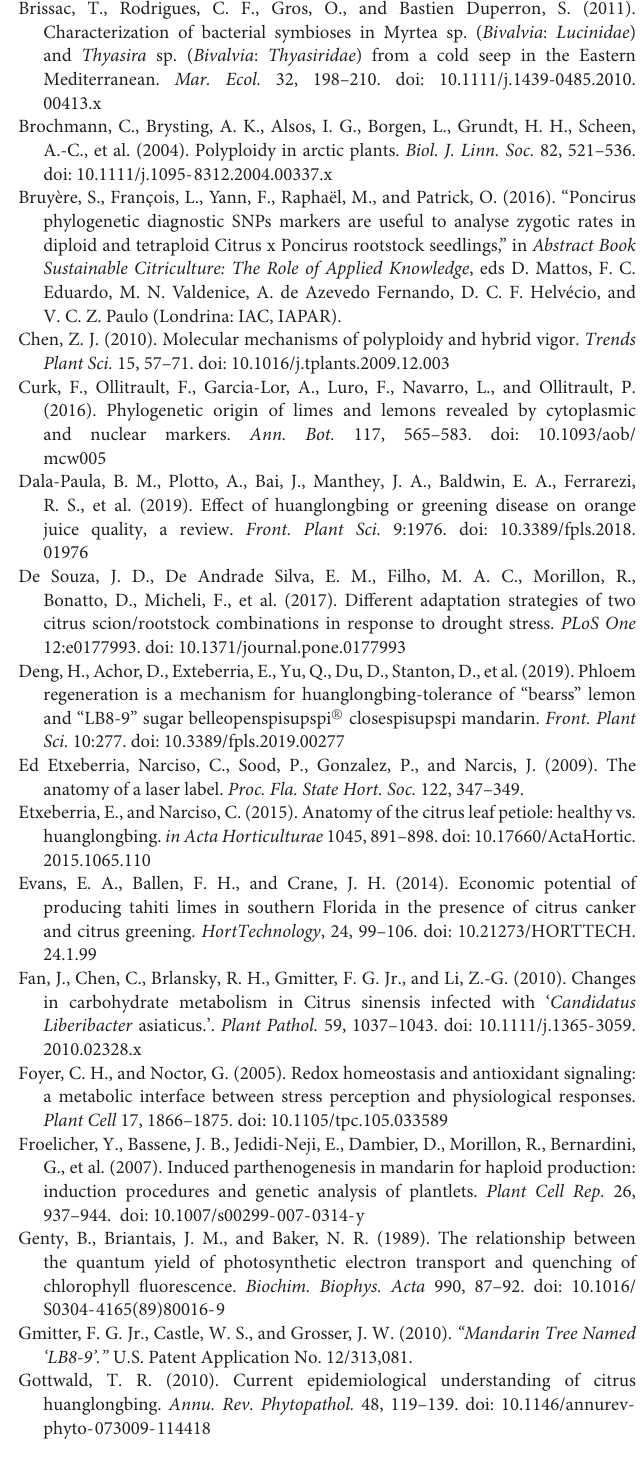
Supplementary Figure 1 | Fish analysis using a probe targeted against Las performed by using the same amount of grounded petiole material of the control (Las − ; A,B ) as well as infected leaves that were asymptomatic (Las + AS; C,D )